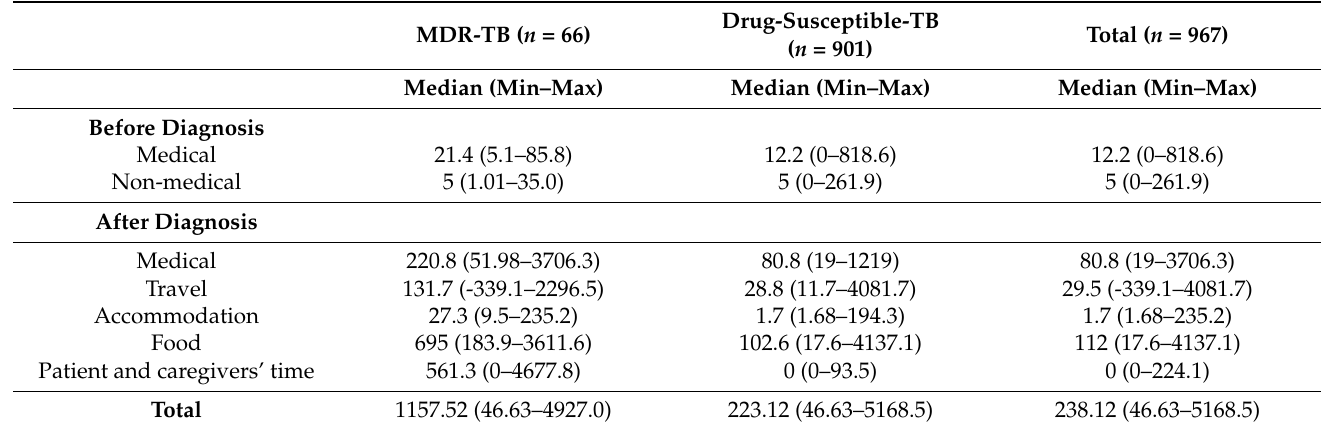
Table 3. Summary of detailed costs in 2015 USD.